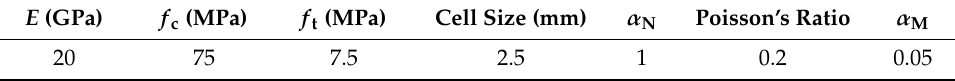
Table 6. Values of input parameters in the numerical analyses about three-point bending test.